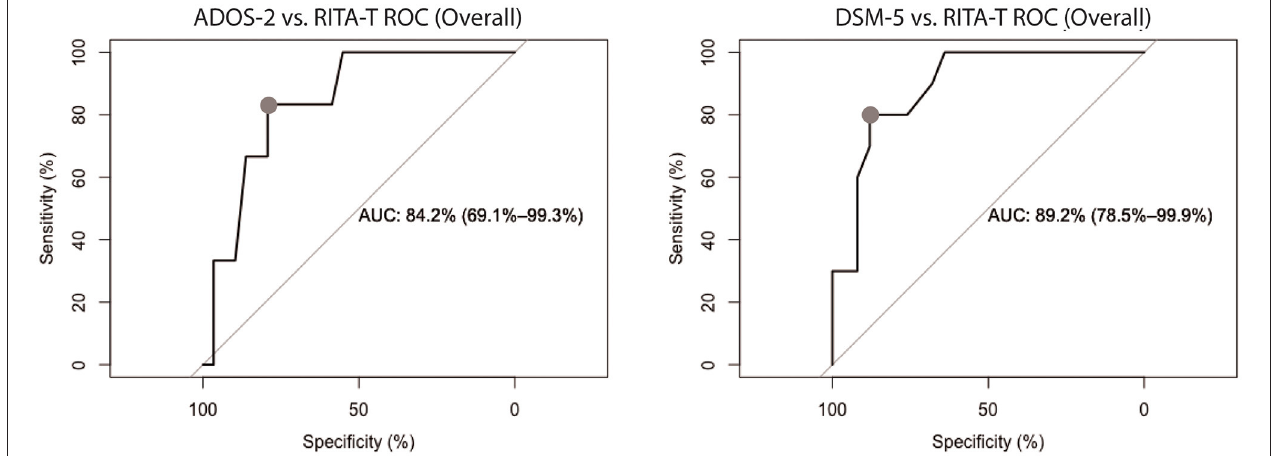
FIGURE 2 | ROC curves of RITA-T in classifying ASD diagnosed by ADOS-2 and DSM-5 in 18 to 84-month old group, separately. The classification demonstrated a RITA-T cut-off score of 14 (dot) with higher optimal sensitivity and specificity. ADOS-2 ROC curve (Left) showed an AUC of 0.842 (95%CI: 0.691–0.993) while DSM-5 ROC curve (Right) indicated an AUC of 0.892 (95% CI: 0.785–0.999).